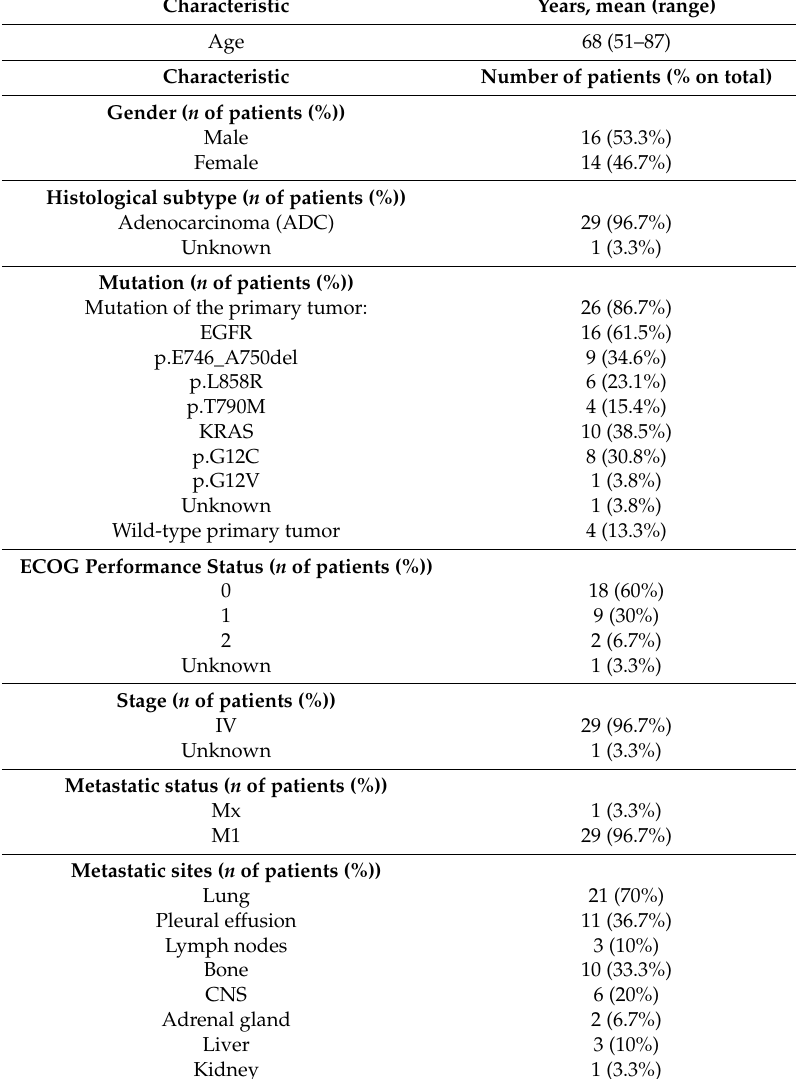
Table 4. Demographic, clinical, and pathological characteristics of the 30 patients